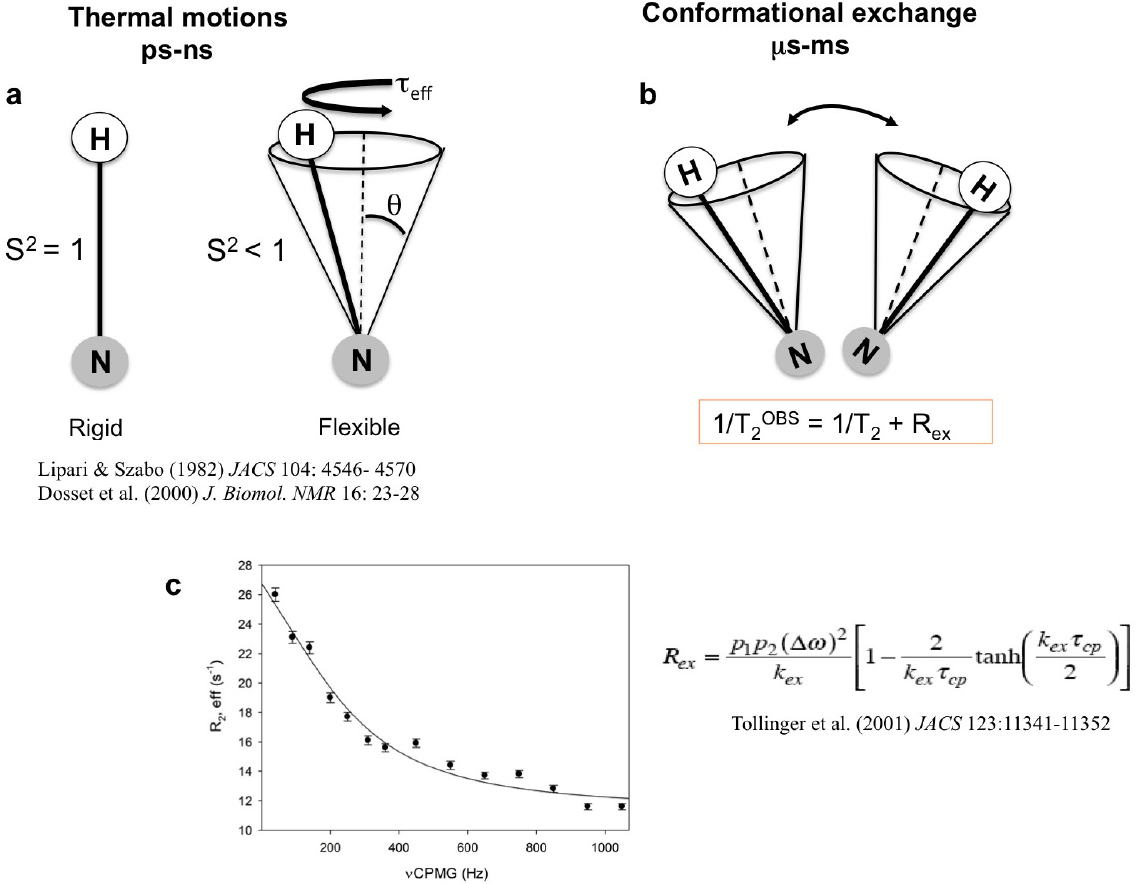
Figure 1. The characterization of pico- to millisecond timescales using spin relaxation measurements can probe internal motions of the bond vector. Model-free analysis of relaxation data (longitudinal relaxation (R ) and transverse relaxation (R )) yield an order 1 2 parameter (S 2 ) that describes the amplitude of motion, a constant ( τ ) describing eff that describes the additional exchange contribution in R its timescale [37–39] ( a ) and R ex 2 ( b ). A representative relaxation dispersion curve demonstrating the dependence of R that ex can be used to extract the populations (p), exchange rates (k) and chemical shifts ( ω ) of ground and exited states (see the equation) [40]. The curve was fitted using CPMGFit program (www.palmer.hs.columbia.edu) [41] ( c